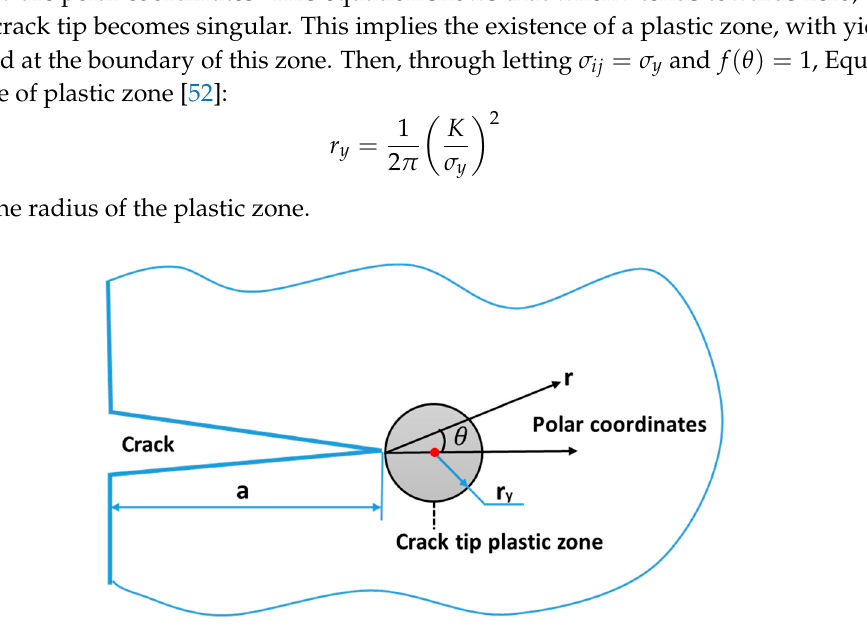
Figure 7. Plastic zone around crack tip.